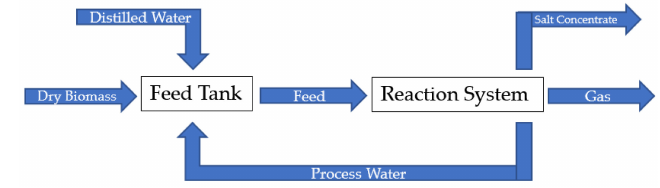
Figure 1. Schematic diagram of the recycling